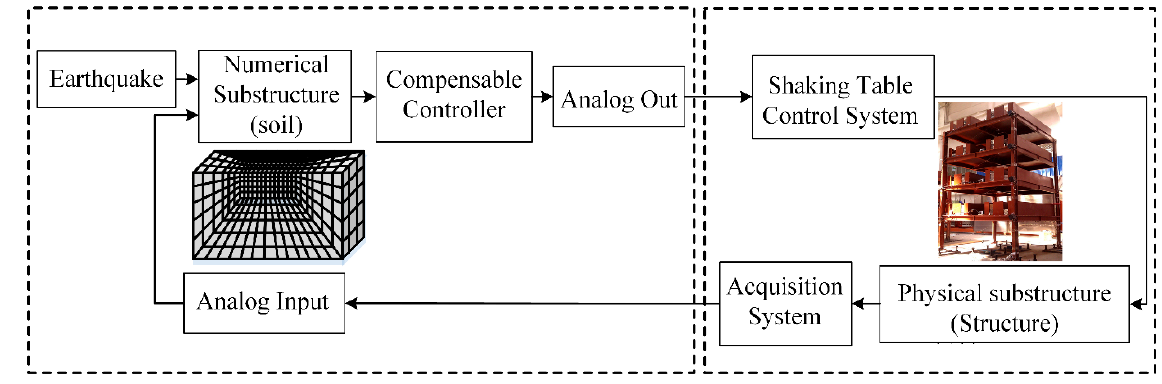
Figure 8. Schematic of real-time hybrid test of the soil–structure system.